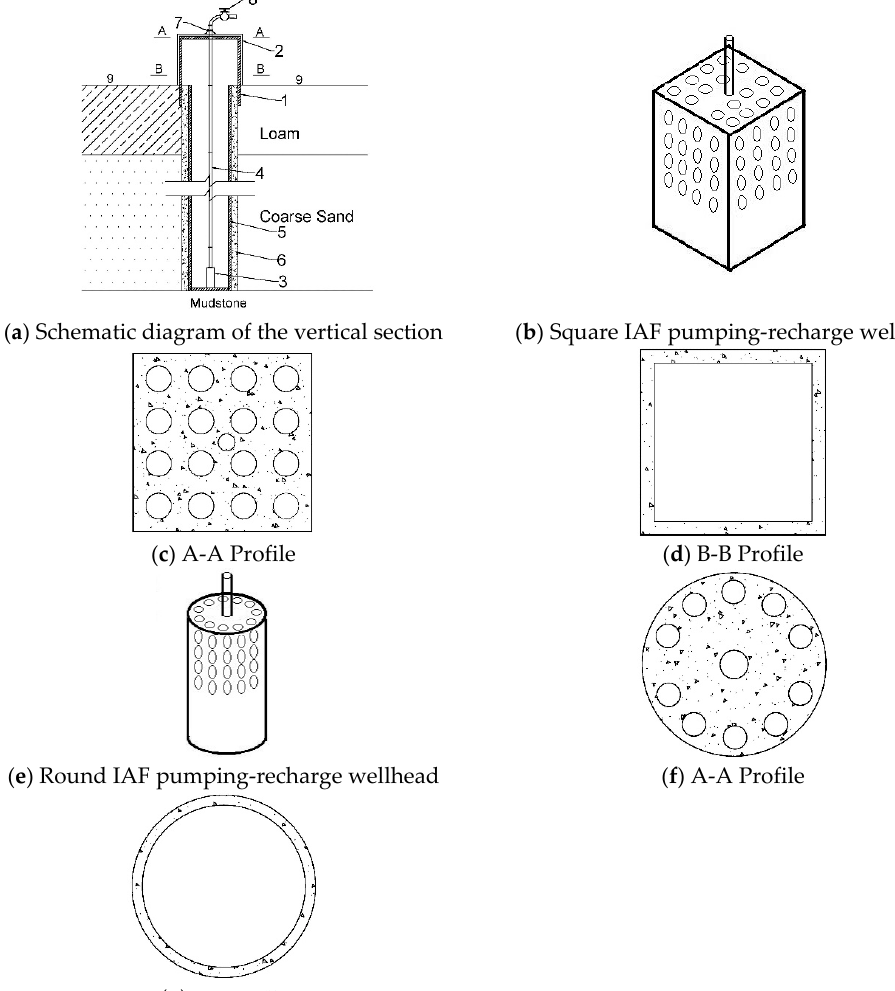
Figure 2. Structural diagram of the IAF pumping-recharge well. Figure (a): 1—Geotextile; 2— Wellheadl; 3—Submersible pump; 4—Water pipe; 5—Recharge well; 6—Filter material; 7— 3—Submersible pump; 4—Water pipe; 5—Recharge well; 6—Filter material; 7—Submersible pump Submersible pump bracket; 8—Water pump valve; 9—Ground. bracket; 8—Water pump valve;